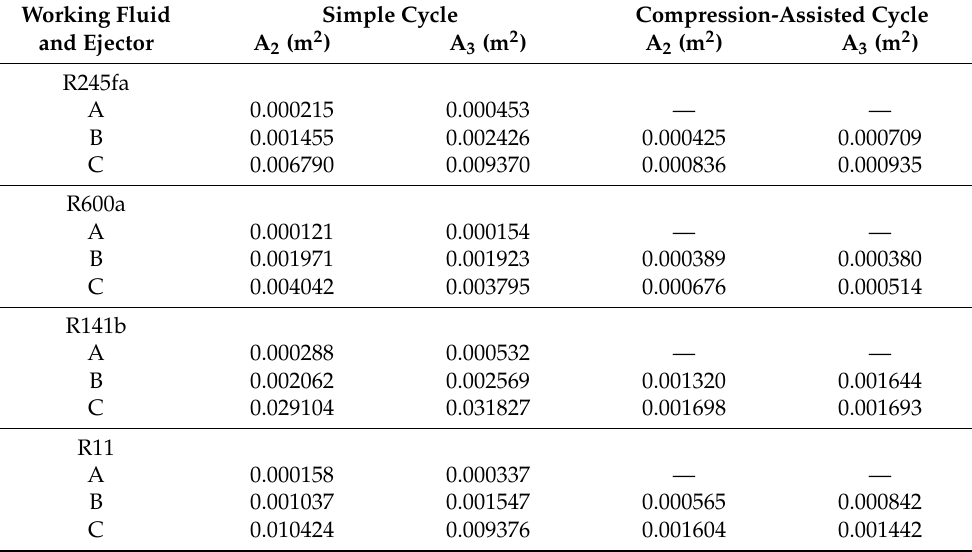
Table 5. Effective ejector area dimensions (m 2 ) for simple and compression-assisted ejector sub-cycles at nominal